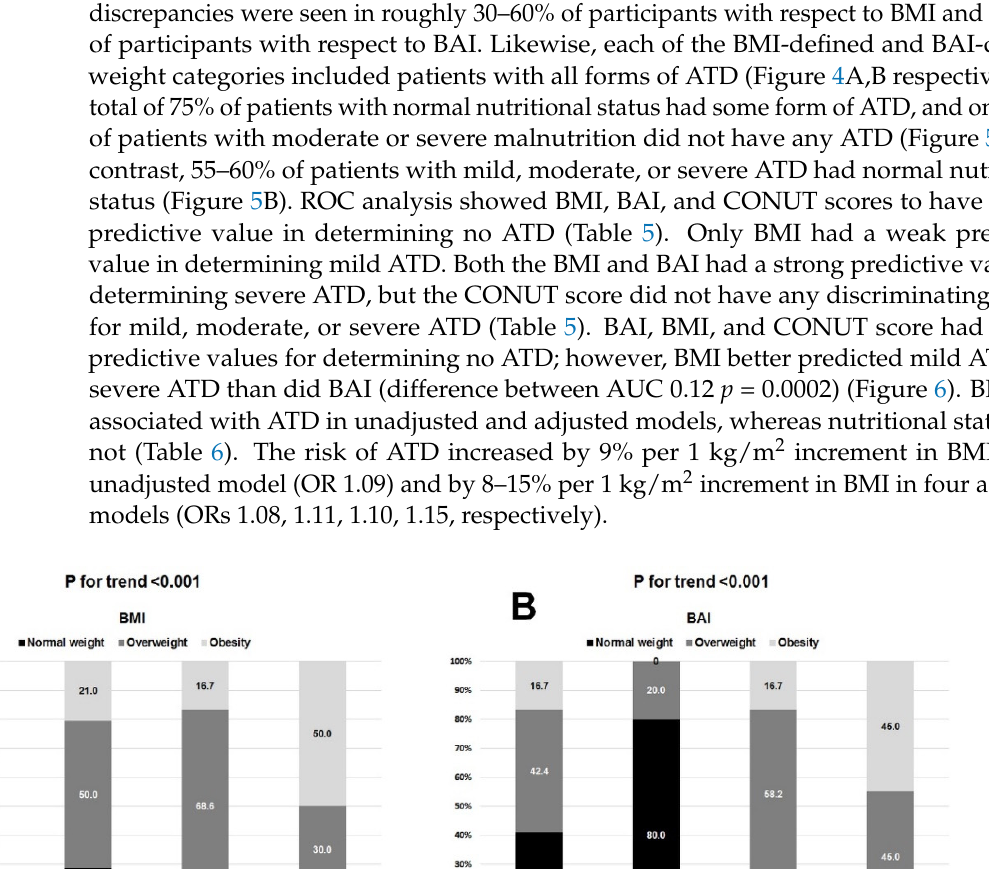
Figure 5. The distribution of VAI-defined adipose tissue dysfunction (ATD) types in respective CONUT score-defined nutritional status ( A ) and the distribution of nutritional status in respective VAI-defined types of adipose tissue dysfunction (ATD) ( B ).